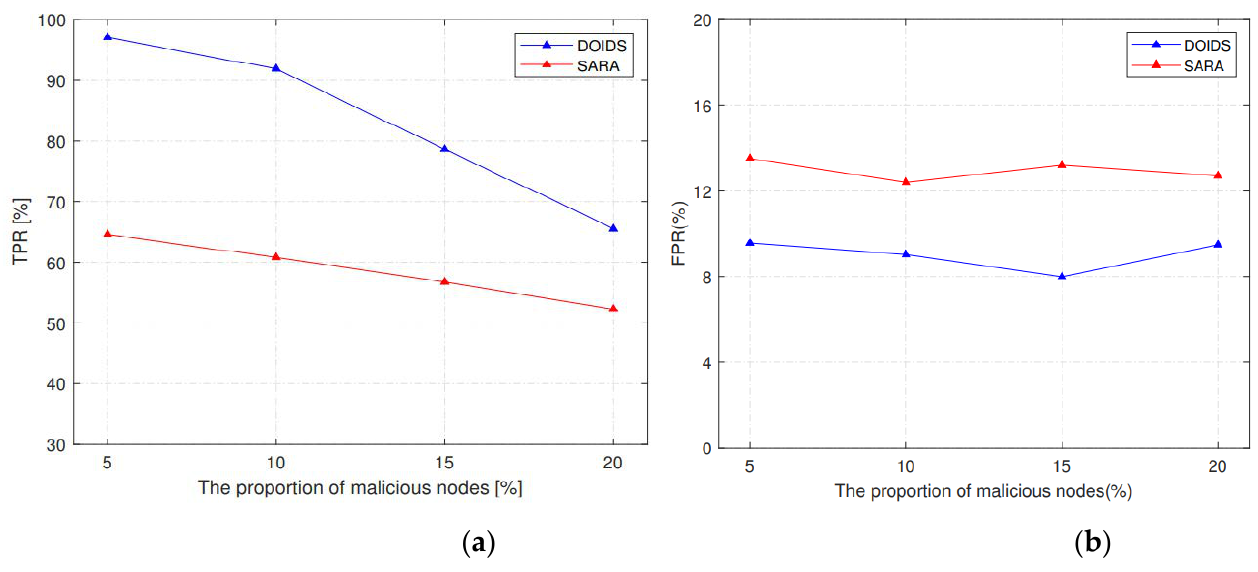
Figure 11. ( a , b ) Comparison between DOIDS and SARA. However, in terms of the decreasing trend of TPR, the scheme proposed in this paper is faster. It is not suitable for many malicious nodes in the network based on the above